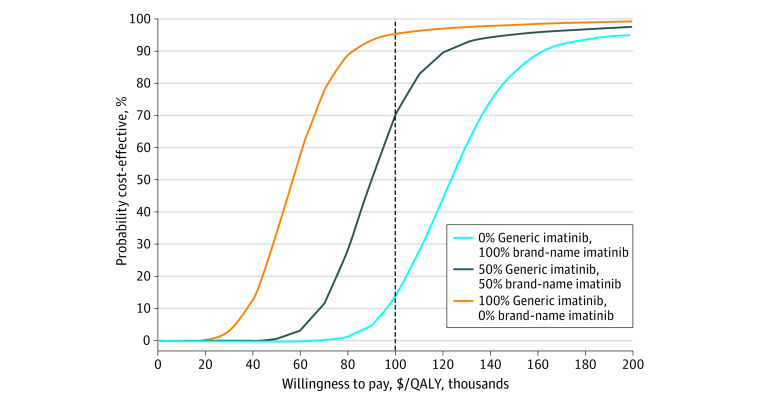
Probabilistic Sensitivity AnalysisDotted line indicates willingness-to-pay threshold.